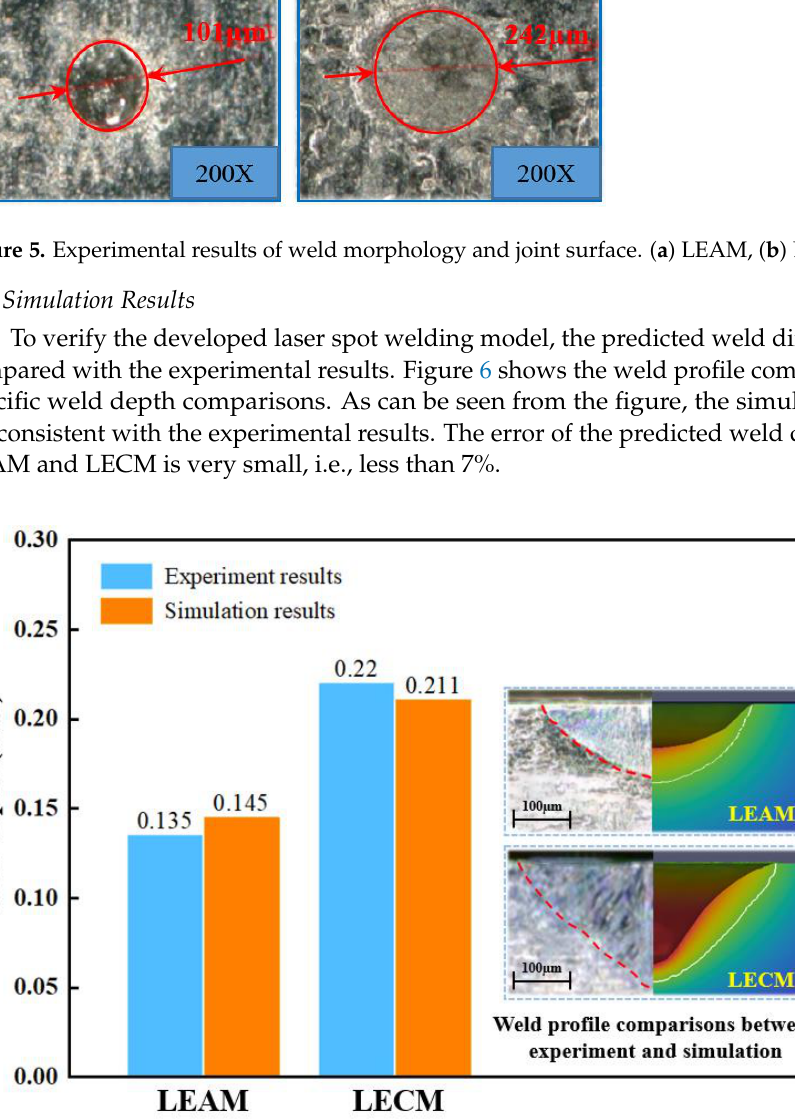
Figure 6. The experimental and simulation results of the weld morphology in LEAM and LECM.